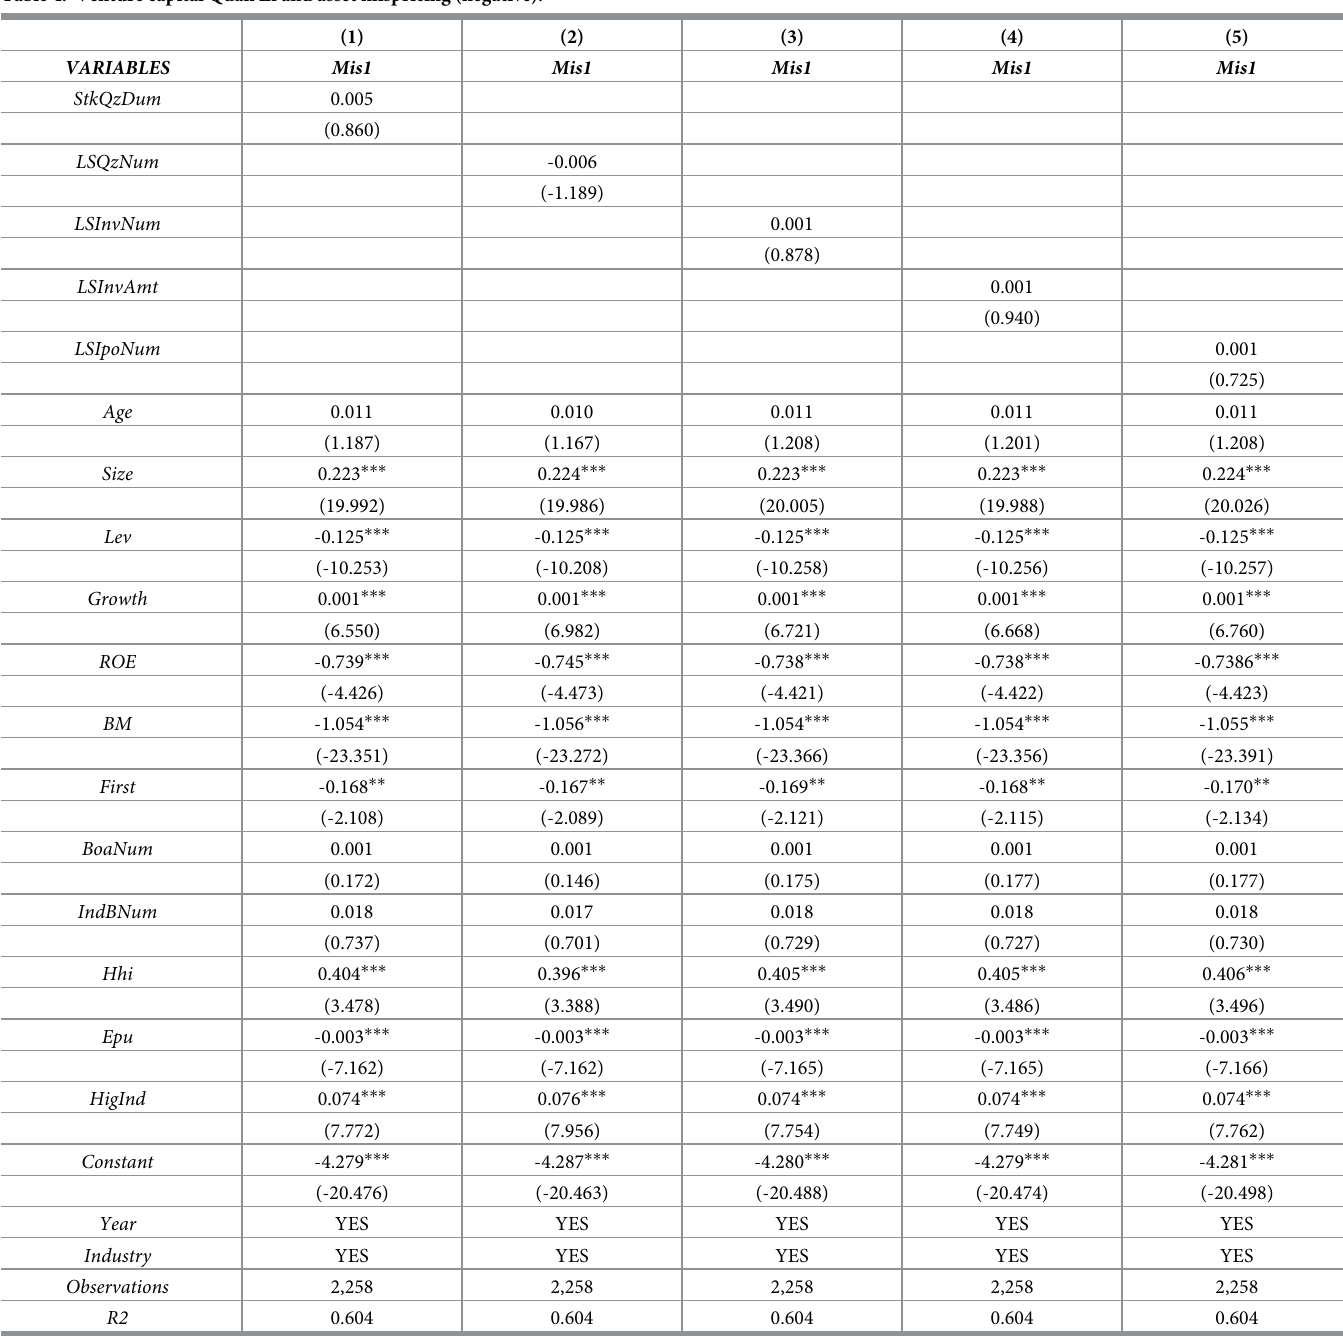
Table 4. Venture capital Quan Zi and asset mispricing